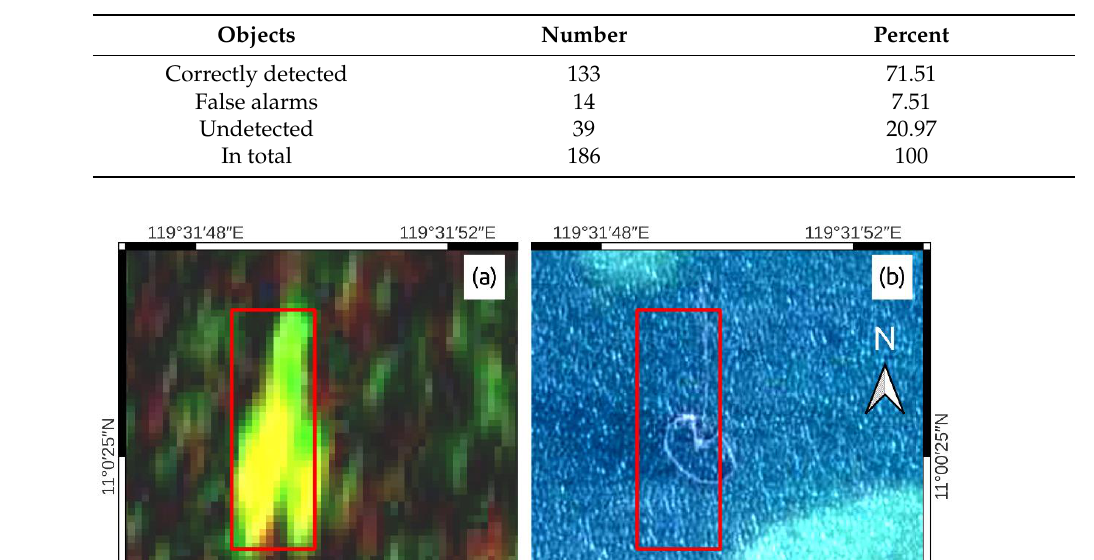
Table 1. Evaluation of aquaculture detector performance based on visual interpretation of Google Earth images.